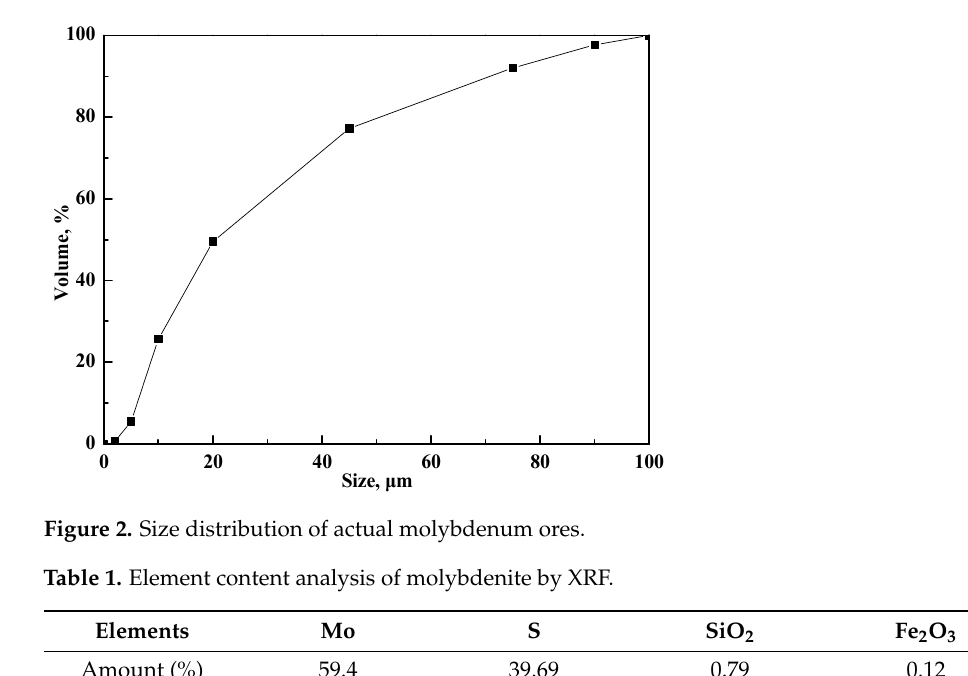
Figure 1. XRD analysis of molybdenite.